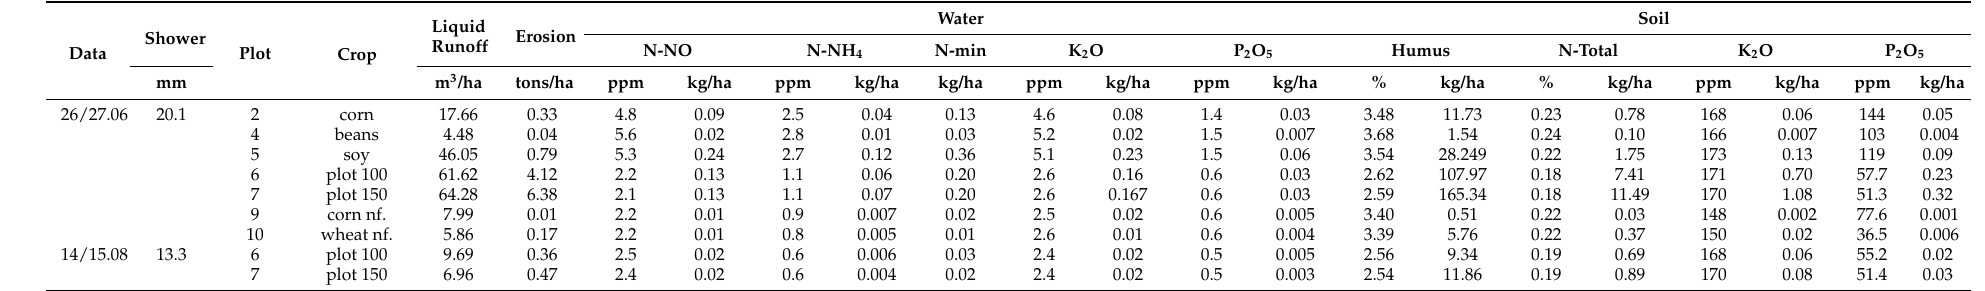
Table 5. Losses of macroelements on showers and plots, SCDCES—MM